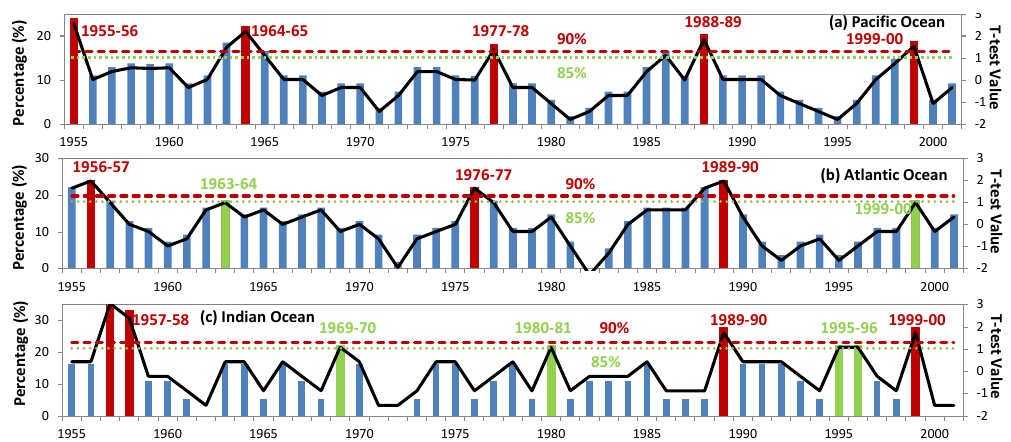
Figure 4. The rate of fish landing regime shift occurrence The percentage of fish landing regime shift occurrences (the bars; left y axis) changes with time based on the statistical results of Table A2 in Appendix and Student t test value (black curves line, right y axis). The red dashed line indicates the threshold of statistical significance t test at the 90% confidence level (right y axis). The red dashed and dotted green lines indicate the statistical significance t test thresholds at the 90% and 85% confidence levels (right y − axis), respectively. The red or green bars indicate the maximum 2-year percentage of regime shift occurrences (passing either the 90 or 85% statistical significance threshold) in each decade for the (a) Pacific Ocean, (b) Atlantic Ocean, and (c) Indian Ocean. The rate calculation is according to total counts of regime shift occurrence during 2 continuous years, the approach is made as follows. For example, during the 10 years from 1971 to 1980 over the Pacific Ocean in Table A2, there are 7 sub-region/fish species showing the regime shift at year 1977 and 3 sub-region/fish species at year 1978, so there are 10 sub-region/fish species showing the shift in 1977–1978. The total sub-region/fish species is 54 (6 sub-regions × 9 species = 54) over the Pacific Ocean, so the rate of regime shift occurrence in 1977–78 is 10/54 = 18.5%. The others were obtained in the same way.